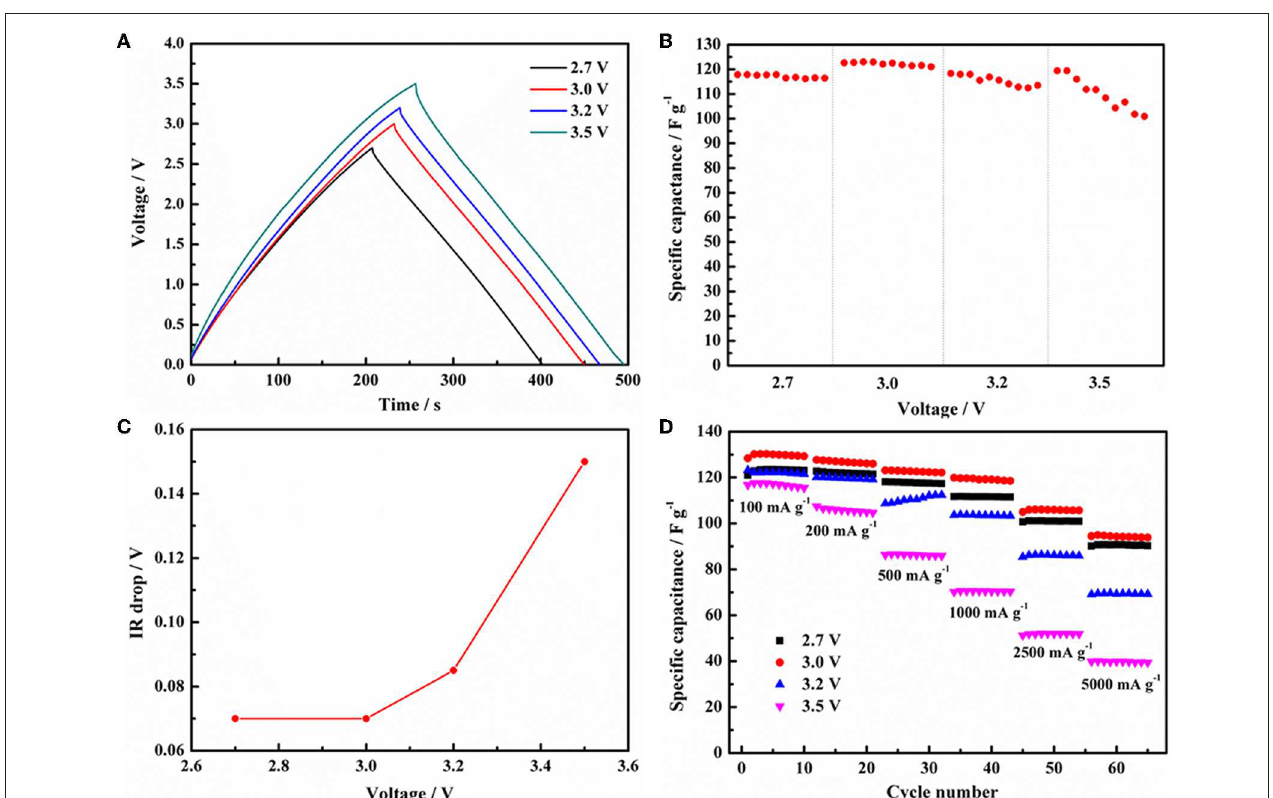
FIGURE 6 | (A) GCD curves of the EDLCs with 1mol L − 1 Py 13 DFOB/PC at current density of 500mA g − 1 with different voltage ranges. (B) Specific capacitance and (C) IR drop vs. voltage obtained from (A) charge-discharge curves. (D) The charge/discharge rates performance of EDLCs with 1.0mol L − 1 Py 13 DFOB/PC under different voltage